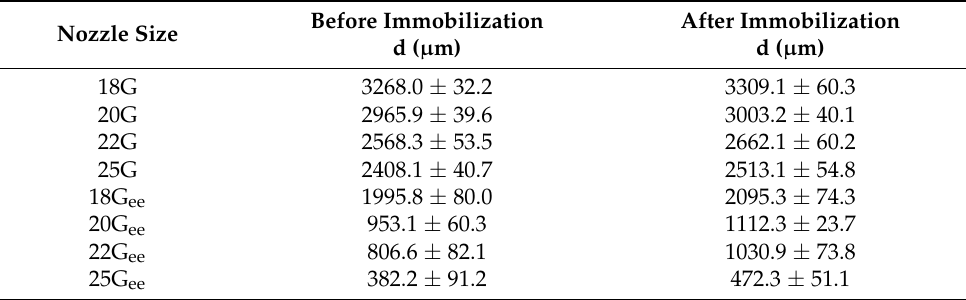
Table 1. Diameter (d) of MABs and HRP-MABs produced by simple dropping and electrostatic extrusion